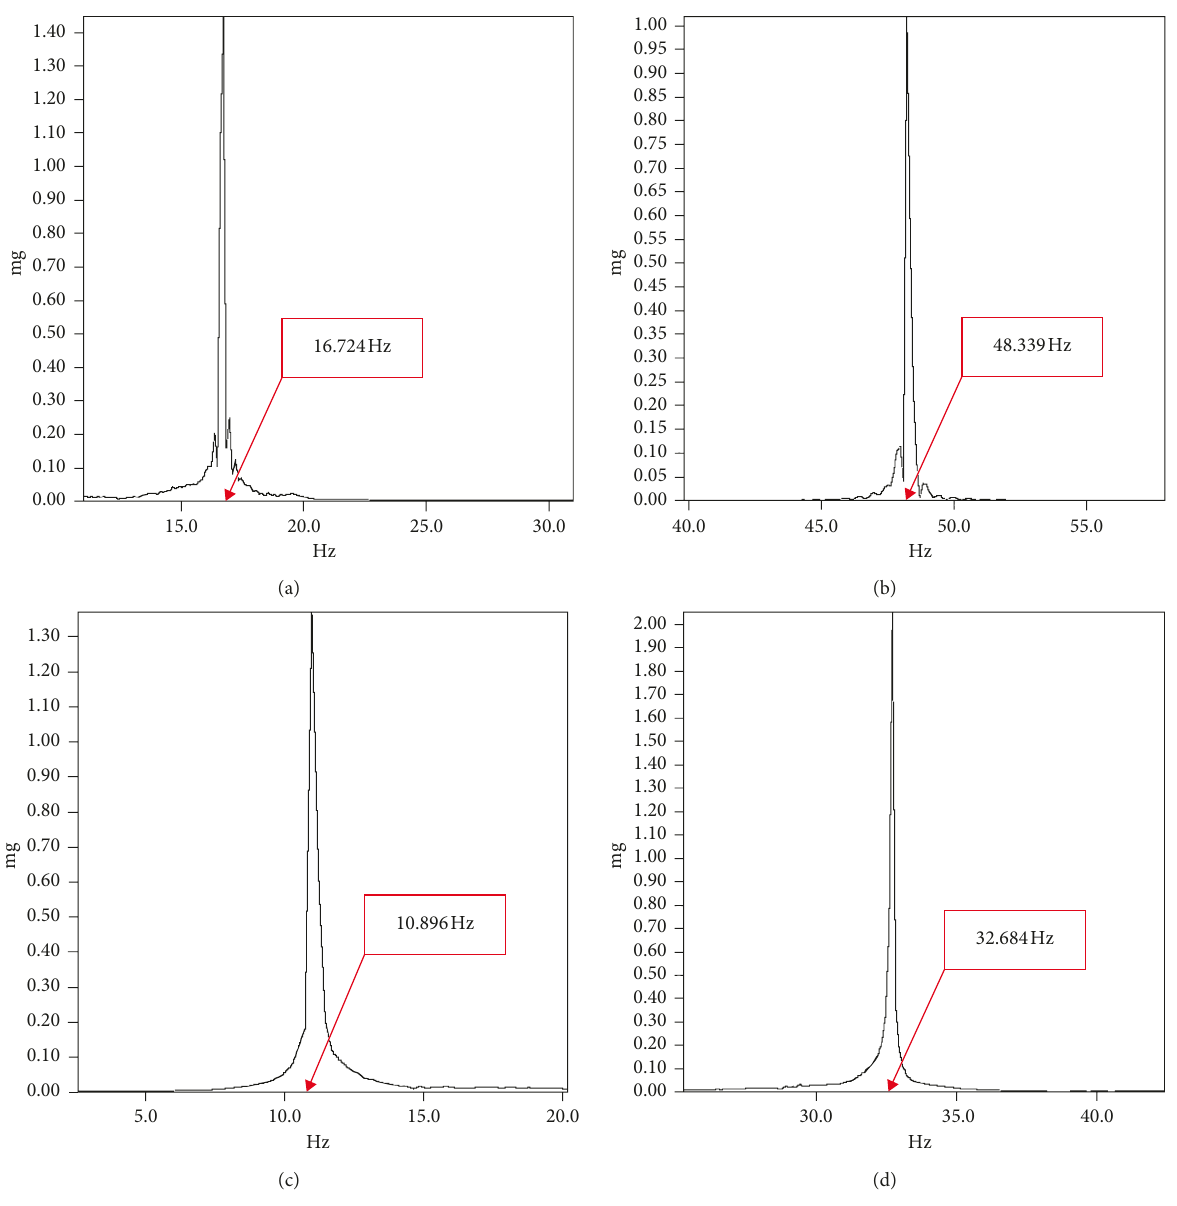
Figure 16: Natural frequency obtained with the forced vibration method. (a) First order in X direction. (b) Second order in X direction. (c) First order in Y direction. (d) Second order in Y direction. Table 1: Natural frequencies obtained from two